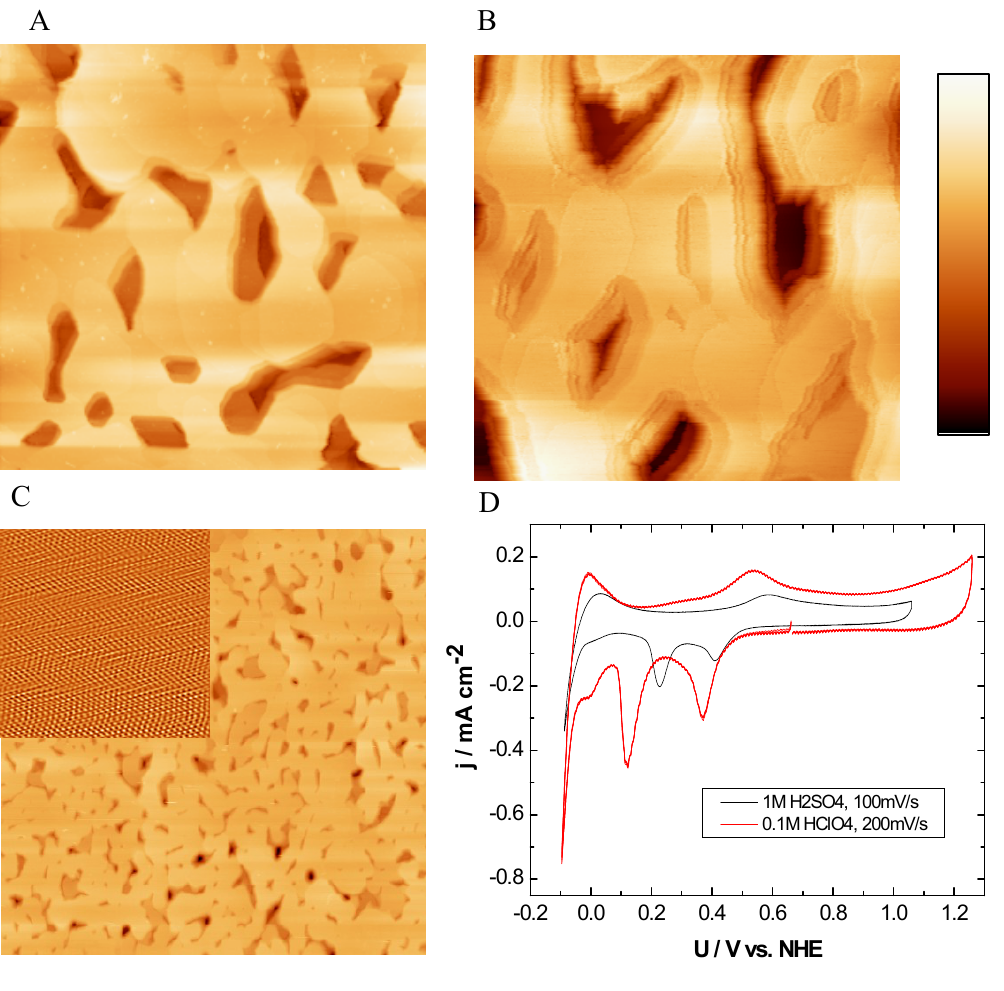
Figure 2 . EC-STM, SECPM, AFM and CV of Ru(0001): (A) EC-STM (500 nm × 500 nm, = 12.17 nm), U = 500mV vs. NHE, (B) SECPM (500 nm × 500 nm, h = 17.22 nm) h max S max image of Ru(0001) in 0.1 M HClO at U = 500 mV vs. NHE, (C) Contact mode AFM in 4 S air (5 µm × 5 µm, h = 40 nm, Inset: atomic resolution, 12 nm × 12 nm) and (D) CVs max obtained in 1 M H SO (black curve) and 0.1 M HClO (red curve) with a scan rate of 2 4 4 100 mV·s -1 and 200 mVs -1 , respectively. Imaging conditions: STM: I = 1 nA, U = T bias 100 mV, SECPM: ∆ U = 5 mV.